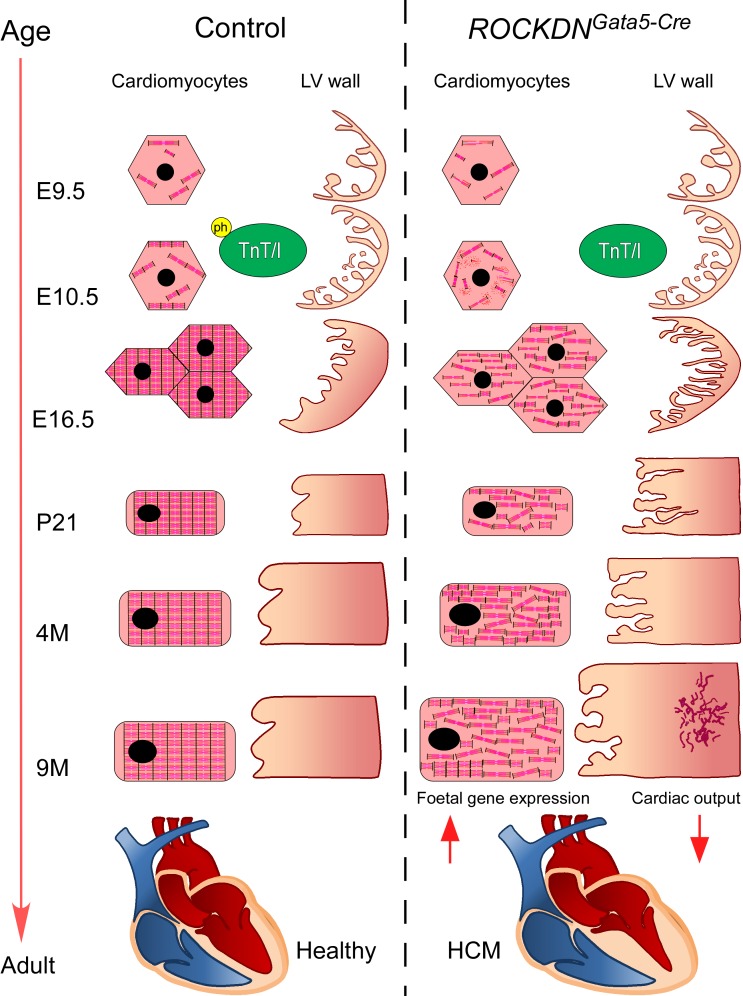
Loss of ROCK function in embryonic cardiomyocytes causes sarcomere disarray, leading to defects in ventricular wall development and compensatory fetal hypertrophy, predisposing to left ventricular hypertrophy, and ultimately HCM in adulthood.Disruption of ROCK signaling in embryonic cardiomyocytes in ROCKDNGata5-Cre mutants led to disruption of the sarcomeric structure and reduced phosphorylation of cTnI, ssTnI, and cTnT at E10.5. This reduced cell proliferation at E11.5 delayed cardiomyocyte maturation, resulting in compensatory fetal hypertrophy of the cardiomyocytes throughout the heart by E16.5. The ventricular wall was significantly thinner and contained myocardial crypts between trabeculae, which along with hypertrophy and disruption of sarcomeric structure continued throughout the life of the ROCKDNGata5-Cre mice. There was a significant increase in left ventricular hypertrophy at 9 months, which led to an increase in expression of fetal genes, patches of fibrosis, increase in left ventricular mass, and reduced cardiac function from 10 months — all of which recapitulate features of the sarcomeric phenotype of HCM. Therefore, the developmental origin of HCM in ROCKDNGata5-Cre mice is sarcomeric disruption in embryonic cardiomyocytes, ultimately triggering pathological left ventricular hypertrophy and maladaptive cardiac remodeling and cardiac dysfunction.